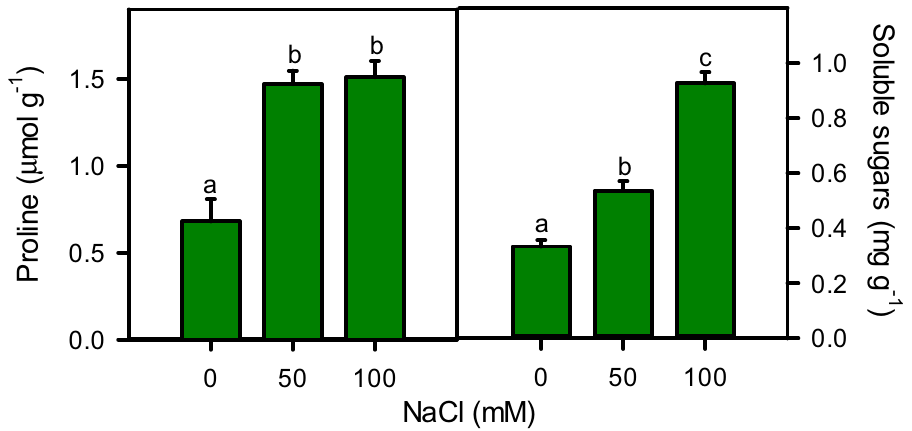
Figure 7. Proline and total soluble sugars of Moringa oleifera leaf under different salinity treatments. Different letters indicate significant differences at P < 0.05.